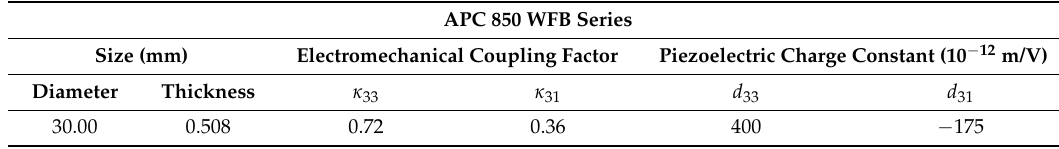
Table 1. PZT material